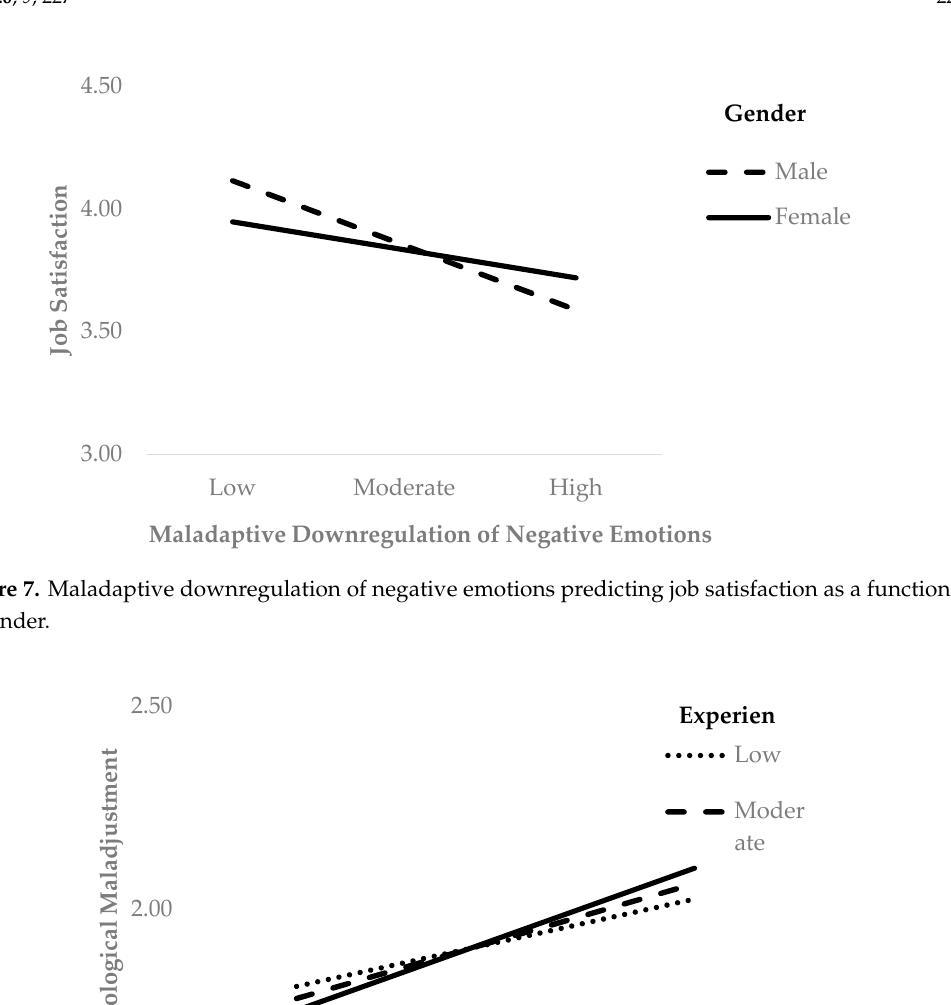
25 of 41 Figure 6. Expressive suppression predicting burnout as a function of gender.